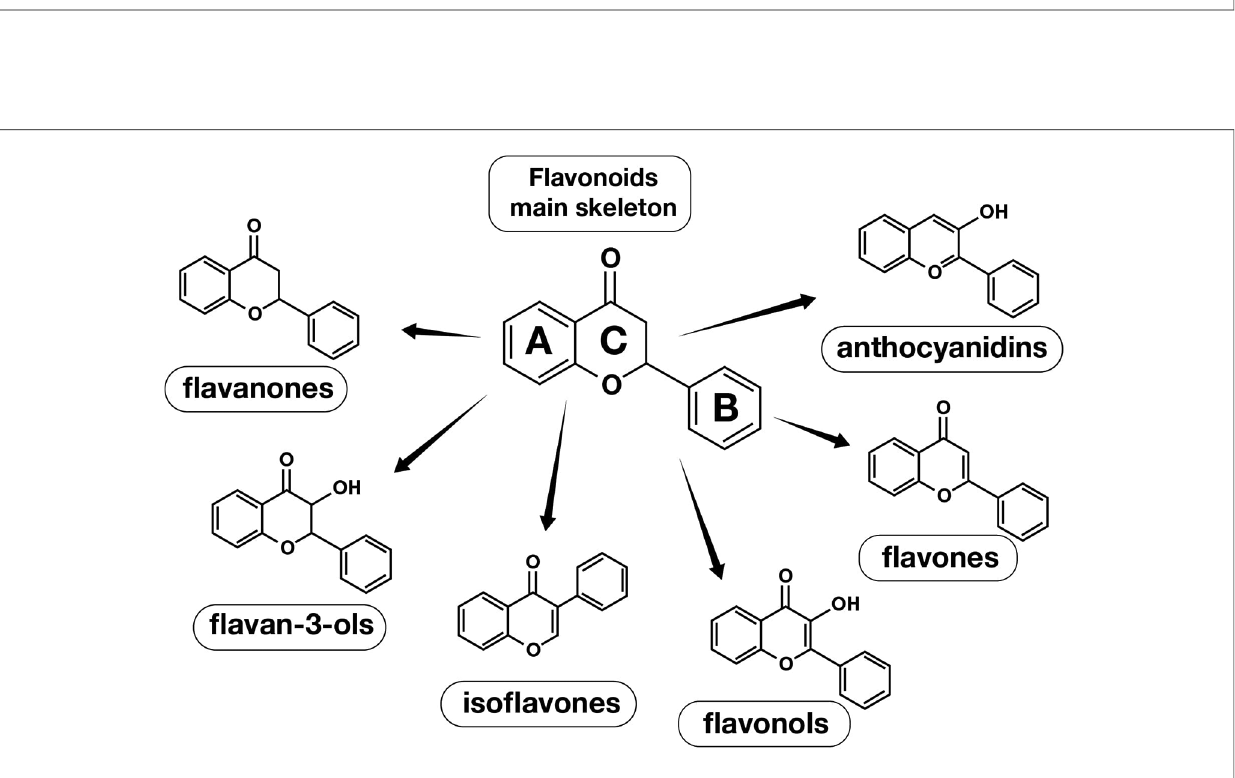
FIGURE 3 Flavonoids main skeleton and chemical structures of fl avonoids different